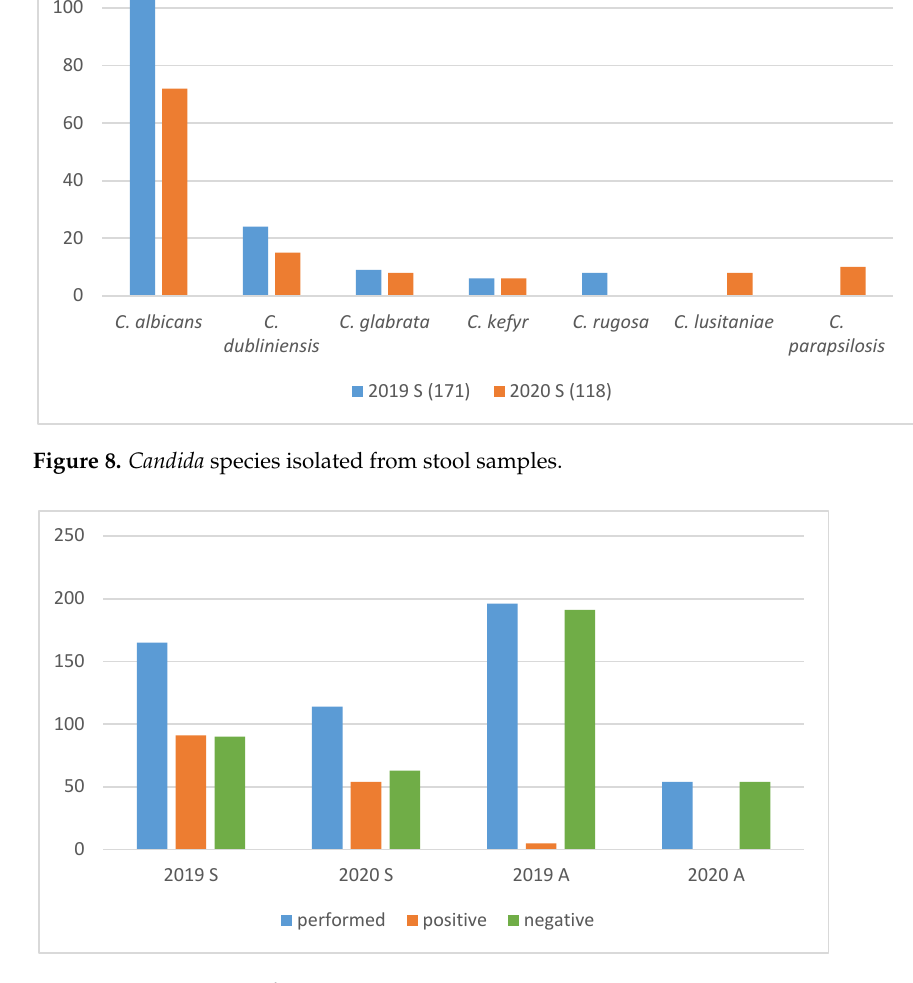
Figure 10. Comparison of Influenza A and B tests. Table 7. Comparison of RSV tests. Period 54 Table 8. Comparison of Influenza A and B tests. Period